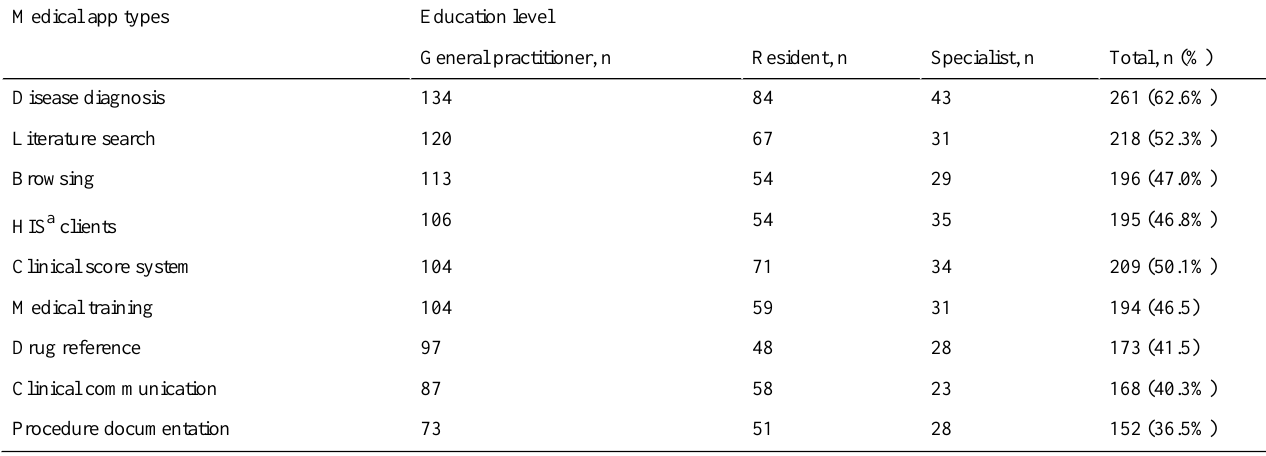
Table 3. Smartphone medical app use at referral hospitals among physicians, 2019 (N=417).